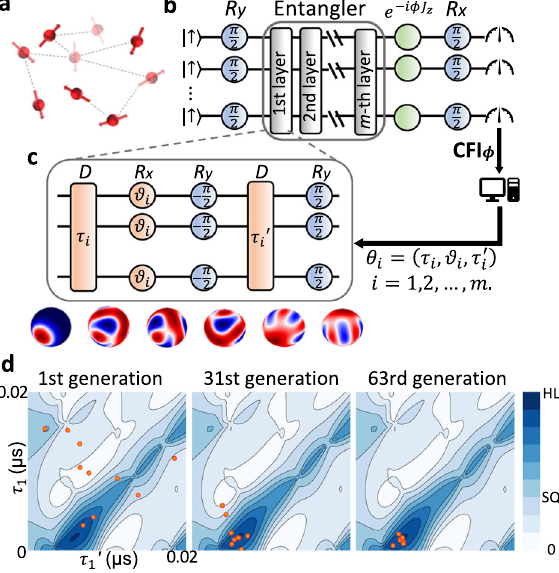
Fig. 1 Preparation of metrological states by variational ansatz. a Schematic of a dipolar-interacting spin ensemble in a 3D-random con fi guration. b The quantum circuit consists of three parts: a sequence for generating entanglement (entangler), phase accumu- lation (Ramsey) and single-qubit readout in the P z basis. Dipolar interactions during Ramsey interference are eliminated by dynami- cal decoupling 7,9,32 . The measurement outcome is processed on a classical computer and used to determine the next generation for θ . c Gate sequence of each variational layer and the Wigner distributions for a 5-spin state after each gate. d Illustration of an optimization process on a 3-spin system with m = 1. The contour plots show the 2D projection of the multidimensional θ space for fi xed ϑ 1 . The orange points mark the sampling positions in the parameter space. Convergence to the global maximum is reached in the 63rd